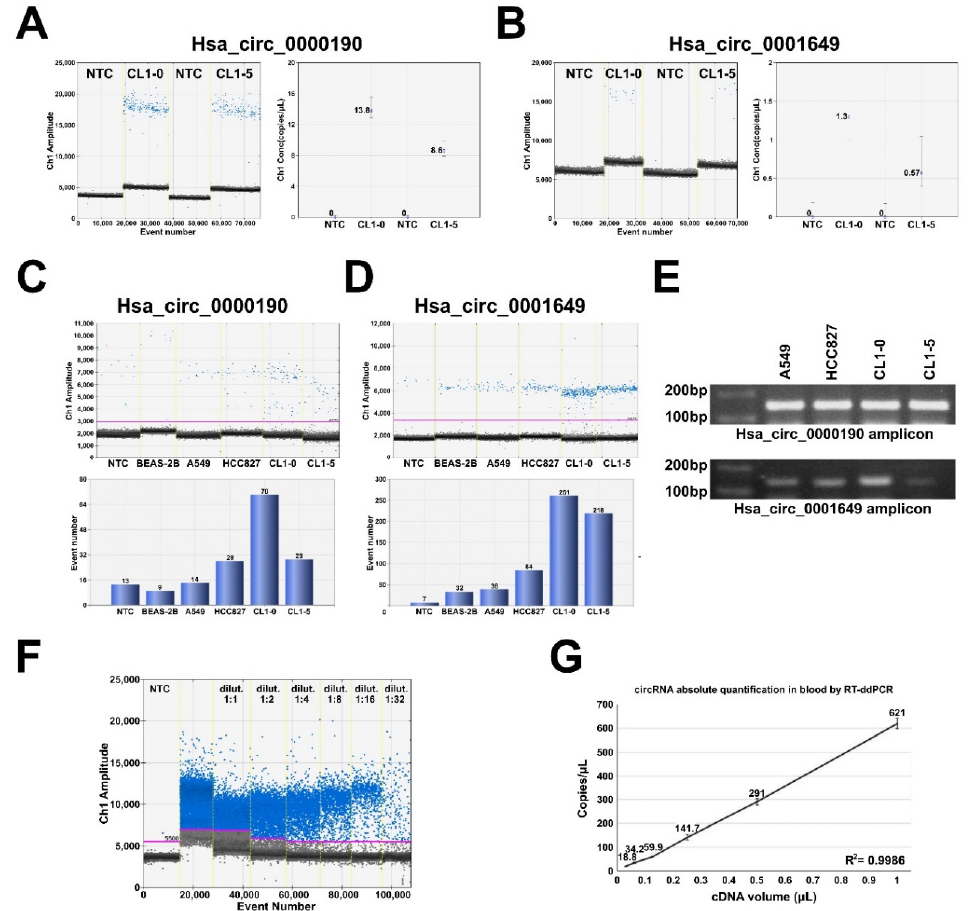
Figure 3. RT-ddPCR detection of hsa_circ_0000190 and hsa_circ_0001649 secreted by LC cell lines and in human blood plasma. ( A , B ) ddRT-PCR analysis of the expression of hsa_circ_0000190 ( A ) and hsa_circ_0001649 ( B ) in the medium conditioned by CL1-0 and CL1-5 cell lines. Left—amplification plot, right—absolute quantification. NTC—no template control. ( C , D ) ddRT-PCR analysis of the expression of hsa_circ_0000190 ( C ) and hsa_circ_0001649 ( D ) in the medium conditioned by BEAS-2B